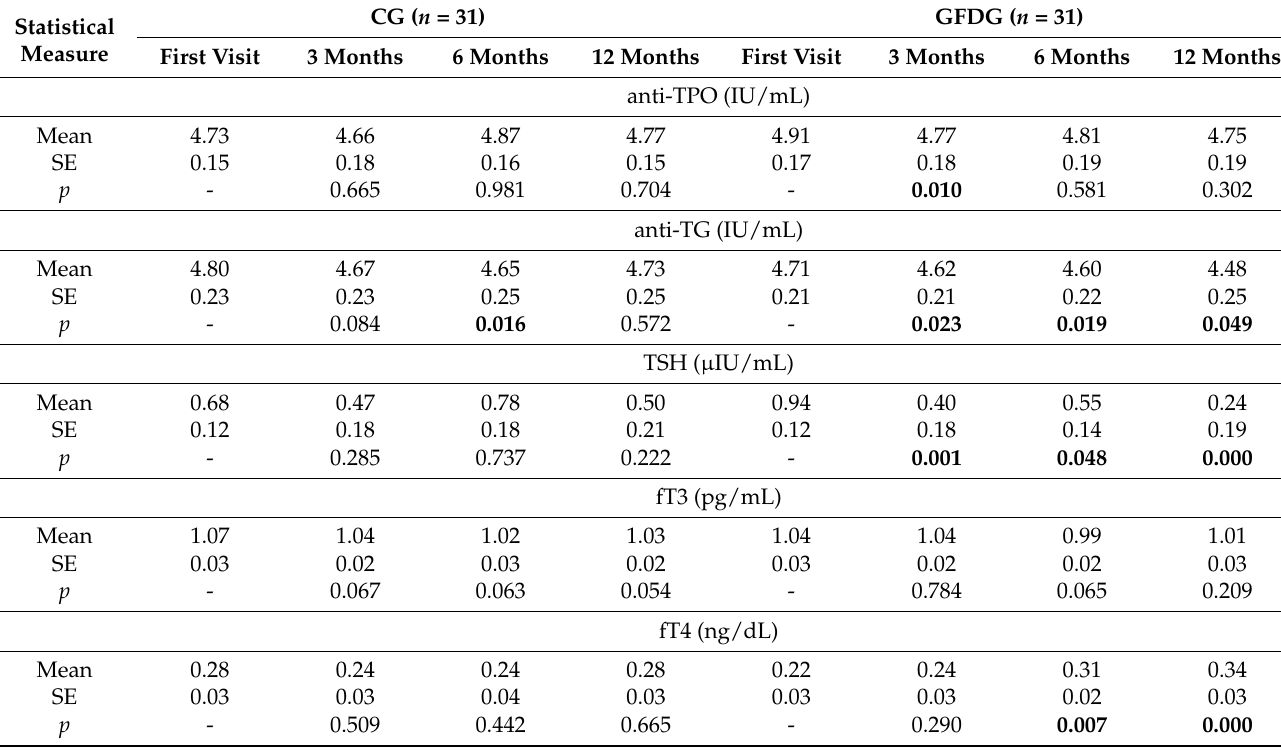
Table 4. Change in concentrations of the tested parameters in CG and GDFG after logarithmic transformation. Statistical